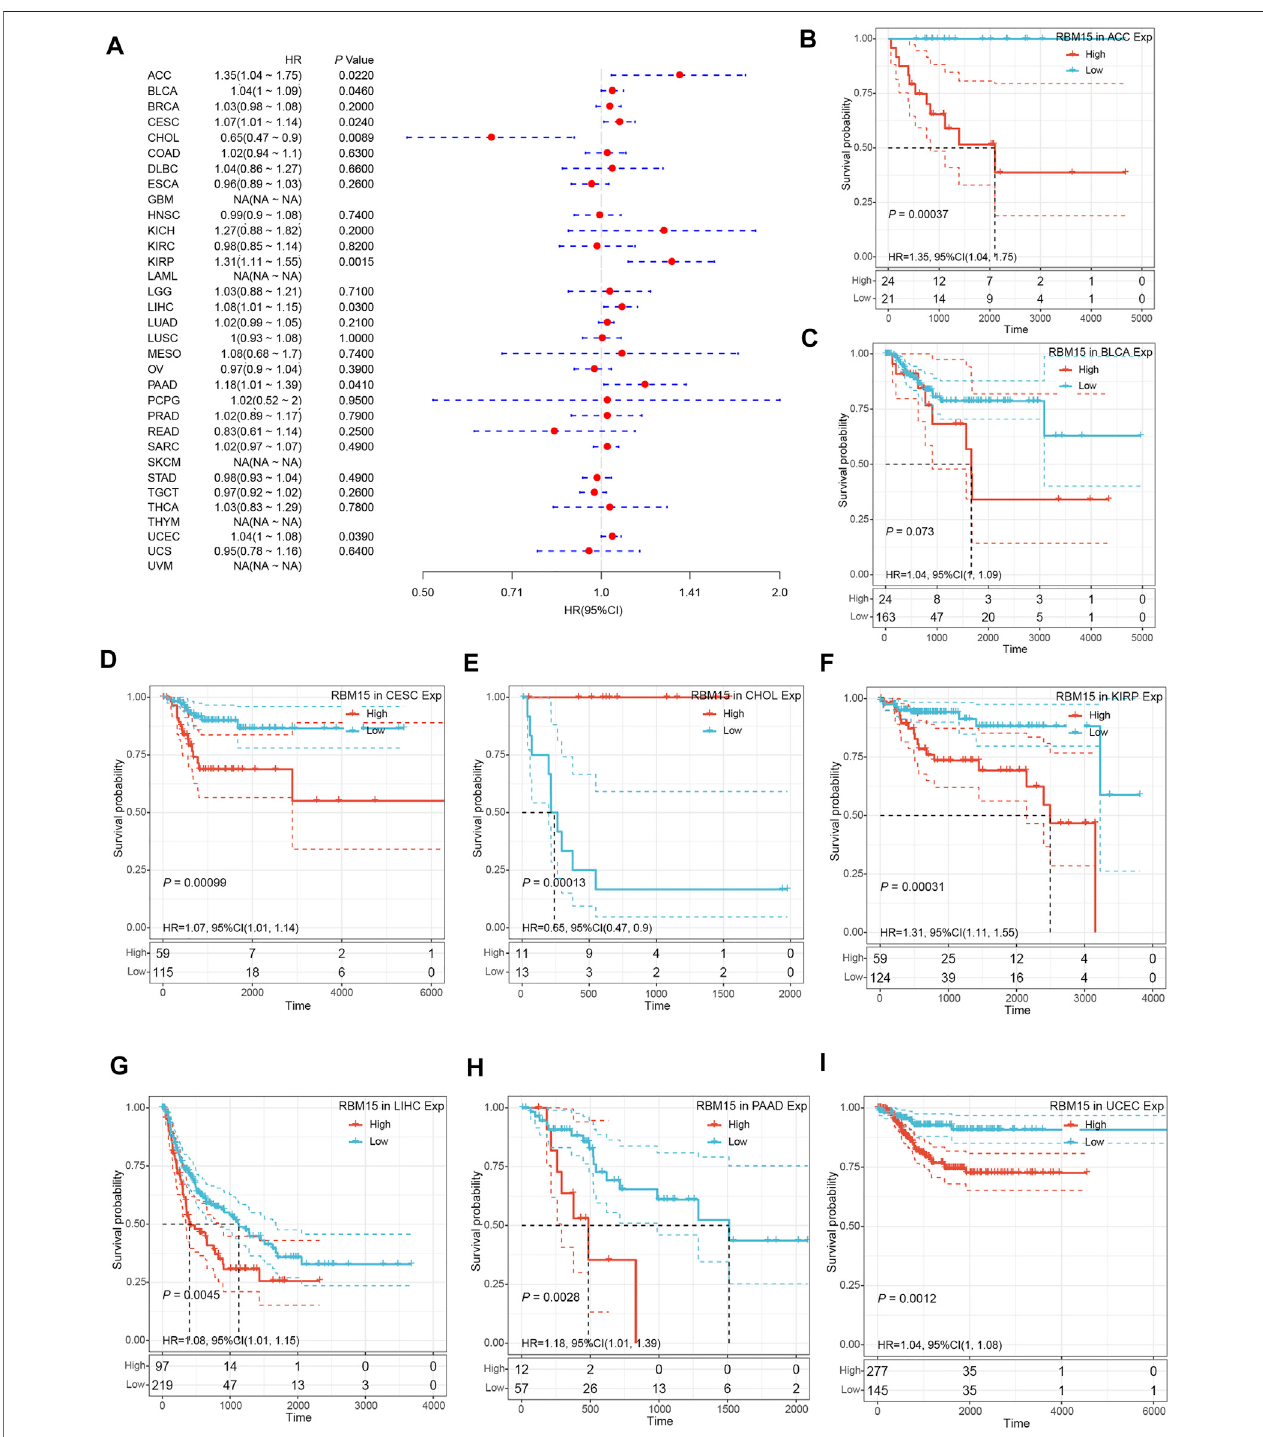
FIGURE 4 | RBM15 expression is correlated with patient ’ DFI. (A) Forest plots of HR for RBM15 expression in 33 tumor types. (B – I) Kaplan-Meier curves of signi fi cant correlation between RBM15 expression levels and patient ’ DFI in ACC, BLCA, CESC, CHOL, KIRP, LIHC, PAAD and UCEC.